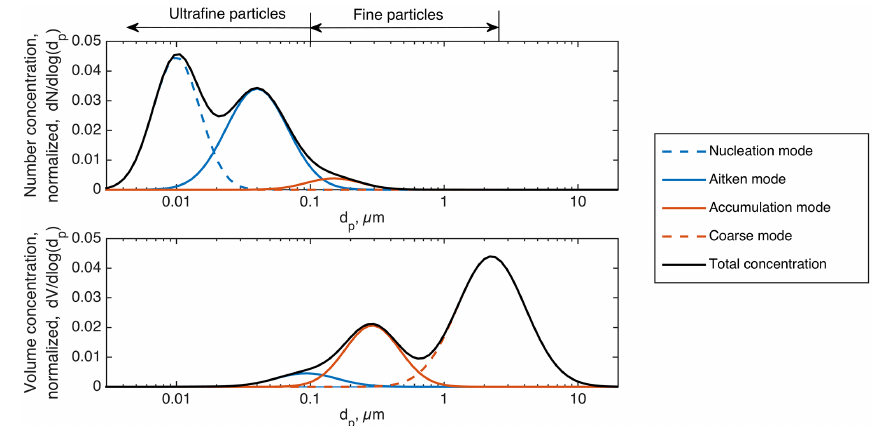
Figure 1. Number size distribution of a fictional and simplified particle population within the planetary boundary layer with four lognormal particle size modes (upper panel) and the same population represented with mass size distribution (lower panel). Note that in the literature it is common to use the term “fine particles” (FP) when referring to all particles with diameters below 2.5µm, including ultrafine particle (UFP) size range. However, in this article we exclude UFP size range from